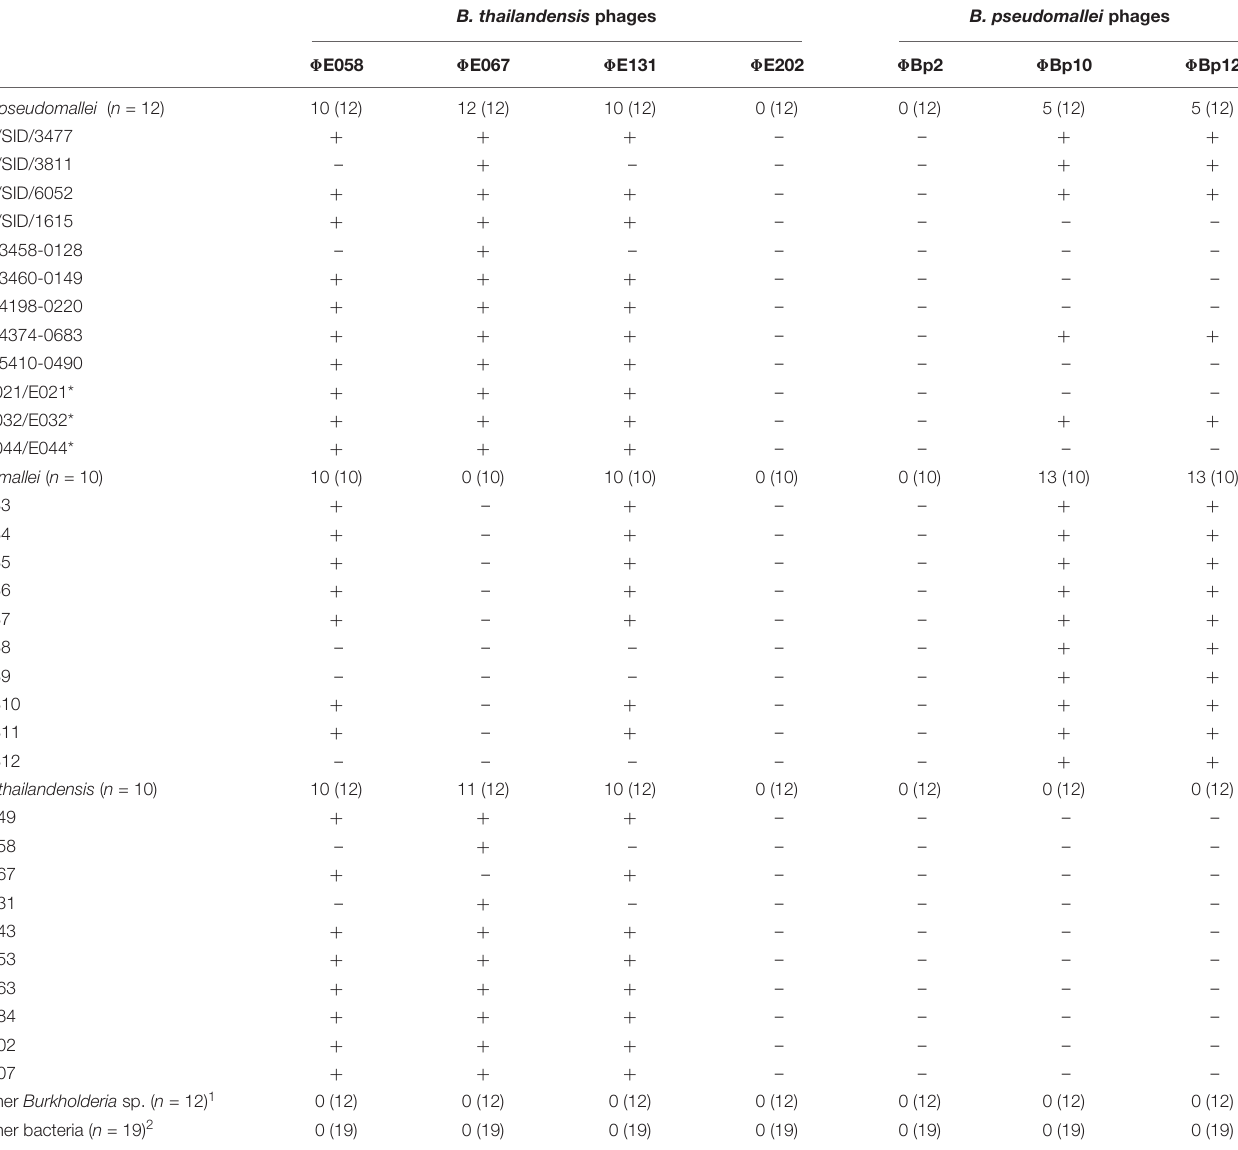
TABLE 1 | Host ranges of the isolated Burkholderia